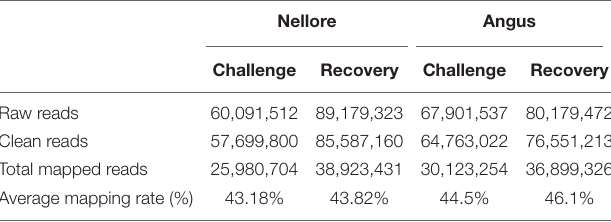
TABLE 1 | Data generated by Reduced Representation Bisulfite Sequencing (RRBS).